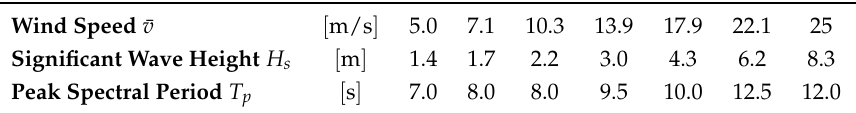
Table 2. Environmental Conditions for Operational Load Cases Extracted from [50], (Krieger, 2016), Chapter 7, with permission from DNV-GL,